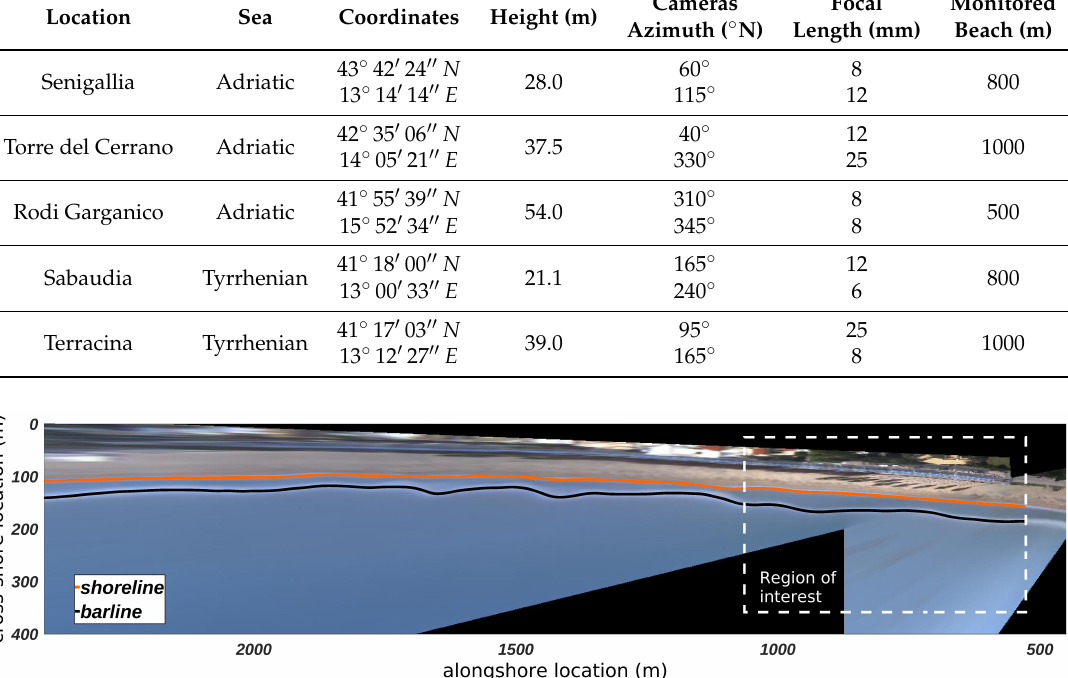
Figure 2. An example of rectified and georeferenced Timex image from the video-monitoring station in Terracina. The remotely sensed locations of the shoreline and the bar are shown with the orange and the black line, respectively. The dashed line box shows the region of interest along the Terracina